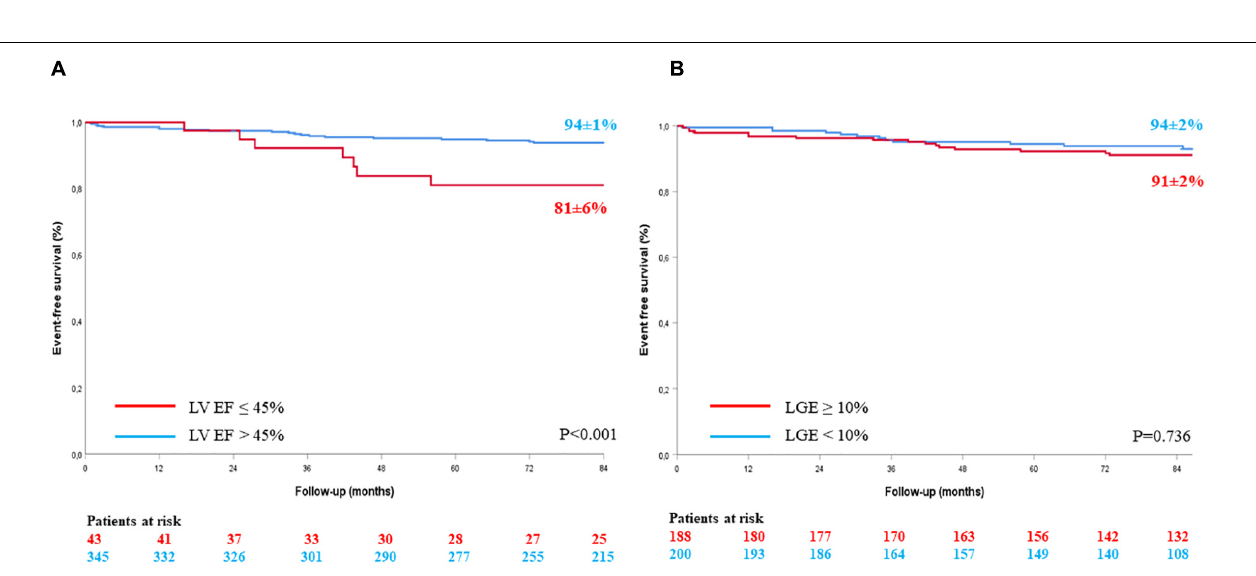
MACE in univariate analysis but not in multivariate